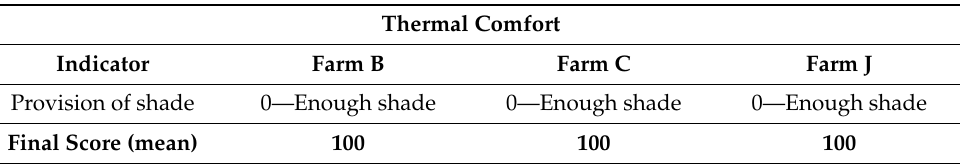
Table 12. Assessment of thermal comfort by way of shade provision.